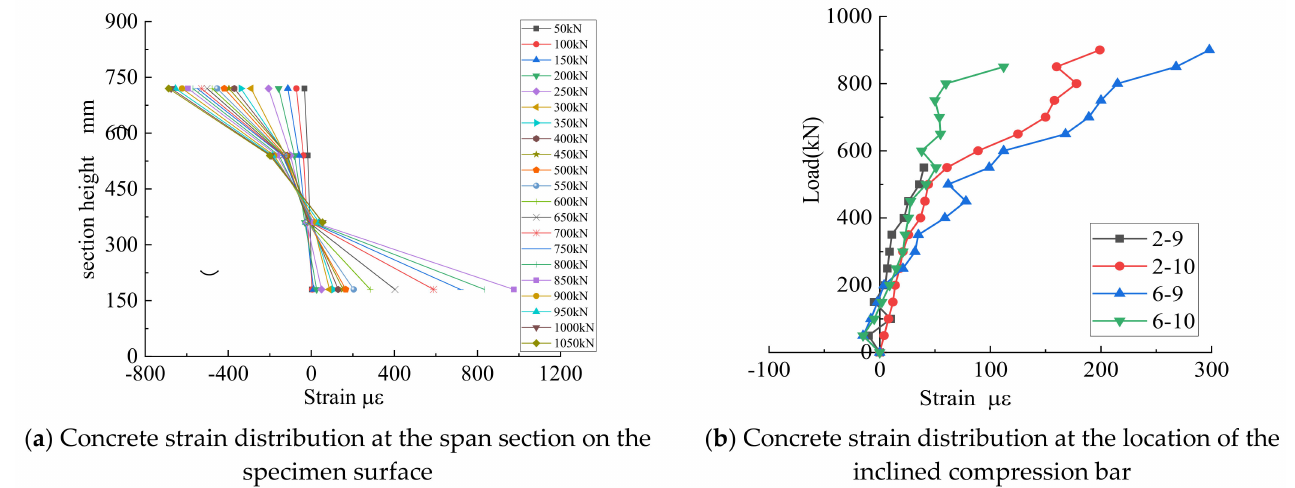
Figure 10. Surface concrete strain of test specimen